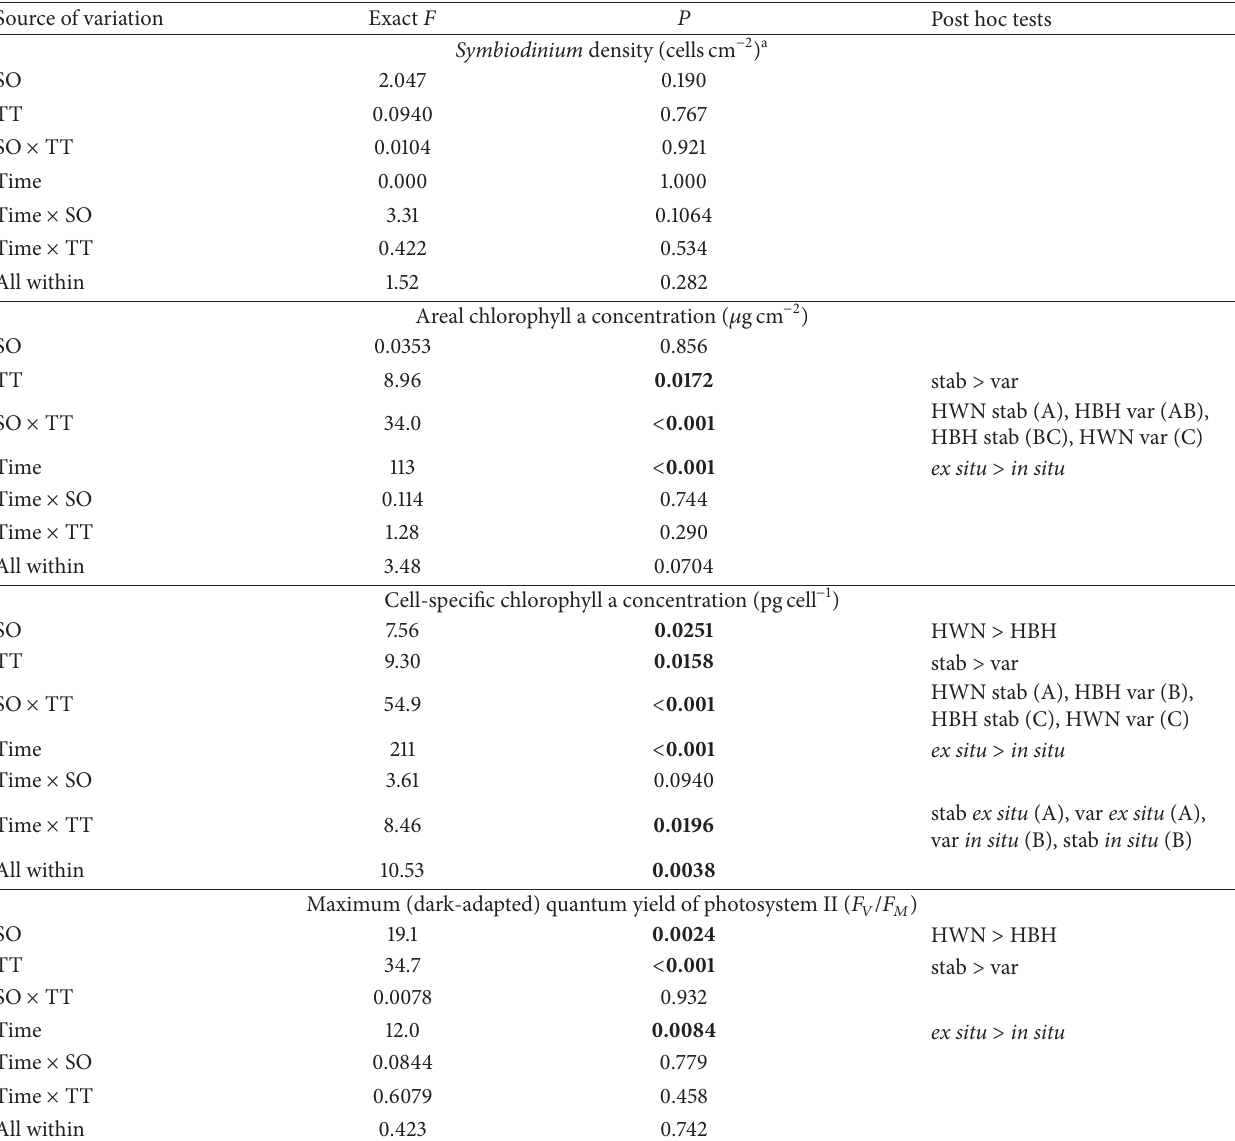
Table 2: Two-way, repeated-measures ANOVA of physiological parameter data. Four physiological response variables were measured both in situ and ex situ (after three weeks of acclimation and one week of experimentation) in corals from either Houbihu (HBH) or Houwan (HWN). “Stab”:stabletemperaturetreatment(TT).“Var”:variableTT.Letterstrailingtreatmentgroupsinthe“Posthoctests”columnrepresentTukey’s honestly significant difference groupings ( 𝑃 < 0.05 ). Site of origin (SO) comparisons were conducted across all data, regardless of TT and sampling time and so do not represent the in situ SO differences, whose values were compared with Student’s 𝑡 -tests or Wilcoxon rank-sum testsandarediscussedinthetextanddisplayedinFigures2(a),2(d),2(g),and2(j).“Time”correspondstothe exsitu versus insitu